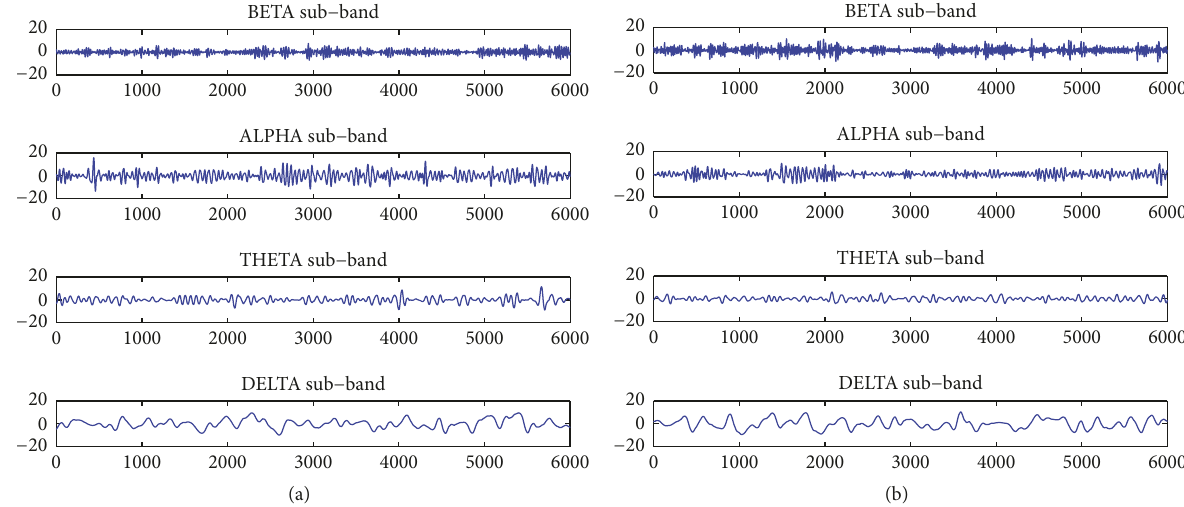
Figure 5: Various EEG subbands obtained using DWT: (a) normal EEG; (b) EEG in